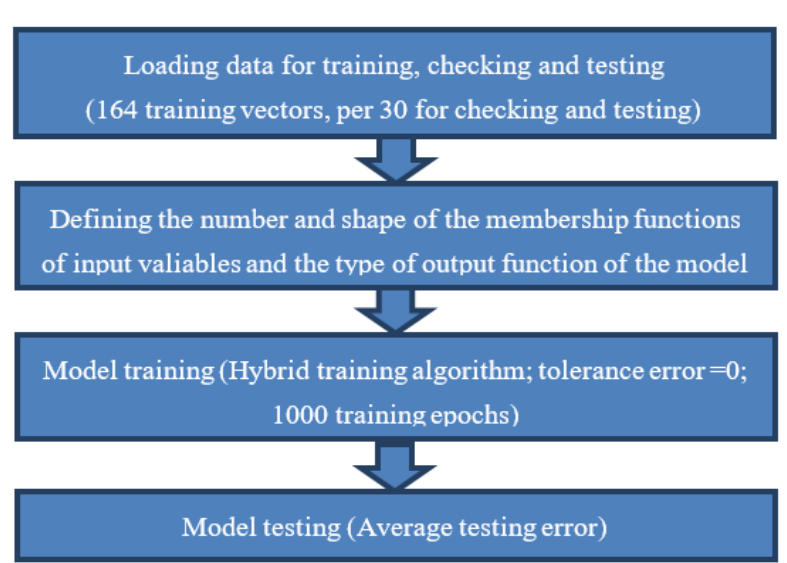
Figure 7. Steps of the process from creation to testing of the ANFIS model.